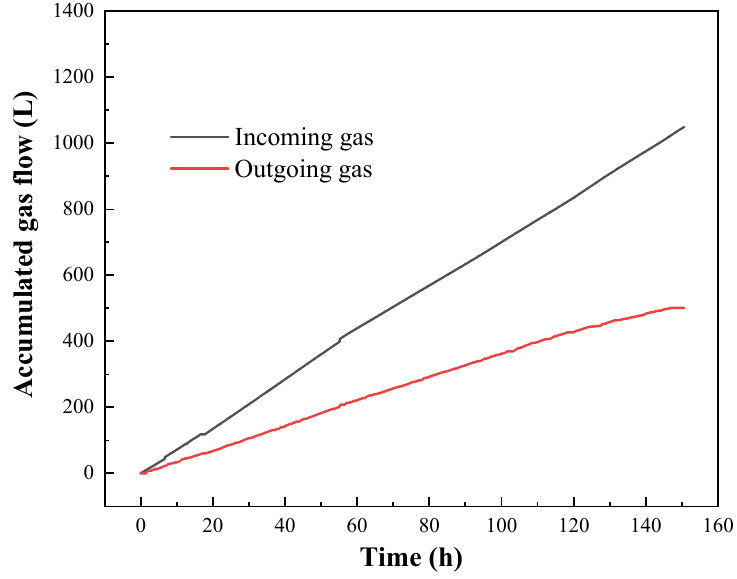
Figure 16. Cumulative incoming CH 4 gas and outgoing CH 4 /N 2 gas changes during the experiment.